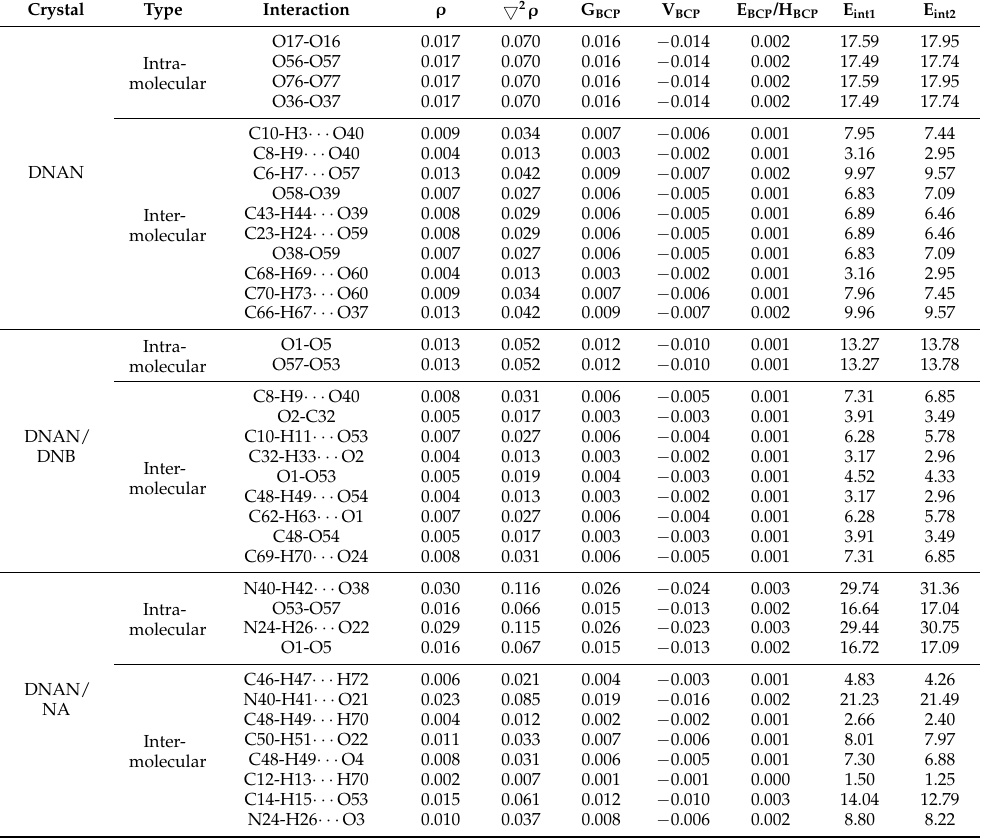
Table 4. Topological parameters of the three DNAN-based crystals at the (3, − 1) critical points: electron densities ( ρ , e Å − 3 ), Laplacian of electron densities ( (cid:53) 2 ρ , e Å − 5 ), Laplacian of kinetic energy (G BCP , a.u.), potential energy density (V BCP , a.u.), energy density (E BCP /H BCP , a.u.), and interaction energy (E int , kJ/mol). For each crystal, the interactions are classified into two types as intra-molecular and inter-molecular